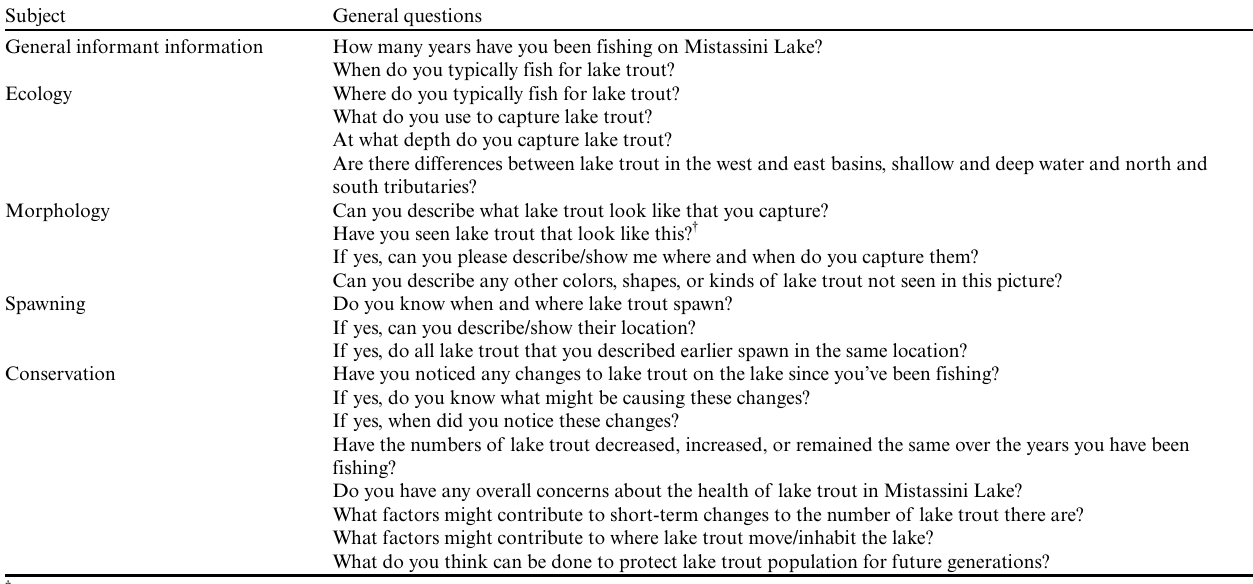
Table 1 . Series of questions used for semidirected interviews with peer-reference